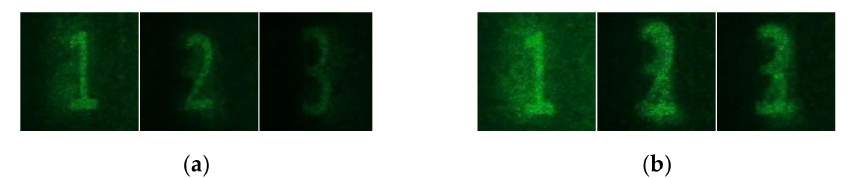
Figure 11. Experimental results of coaxial reconstruction with distinct depth ( a ) with phase-locked algorithm and ( b ) without phase-locked algorithm.